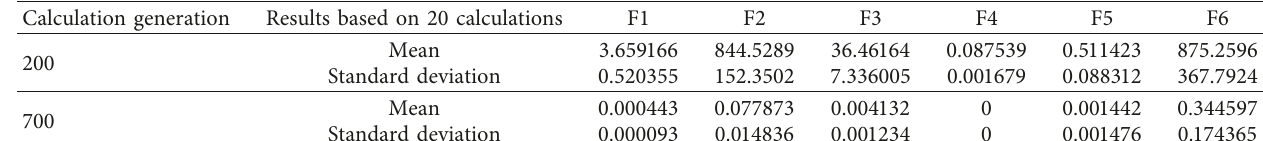
Table 3: Performance of TCABC with different generation numbers.